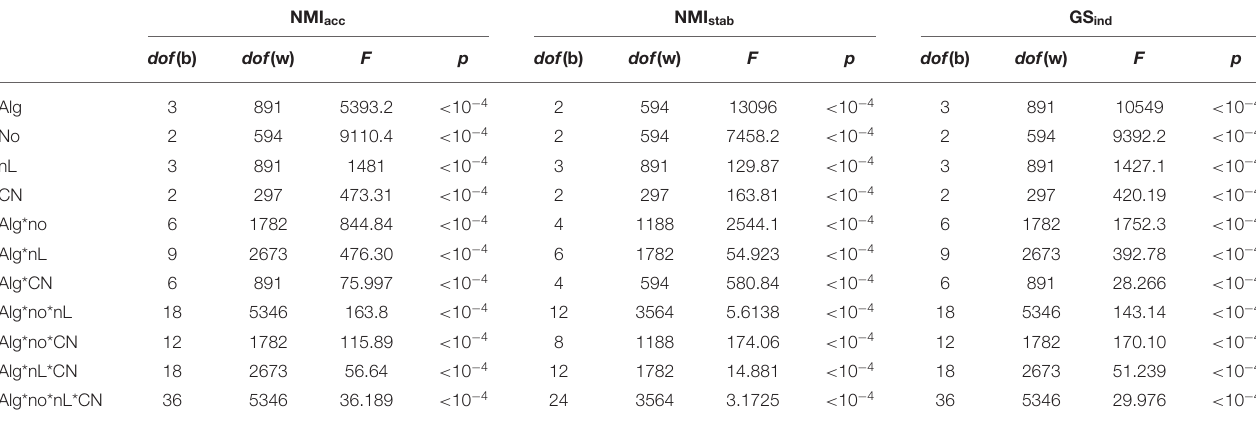
TABLE 1 | Results of the ANOVA test executed for the comparative analysis on networks with stationary community structure and graph density equal to 0.3. NMI